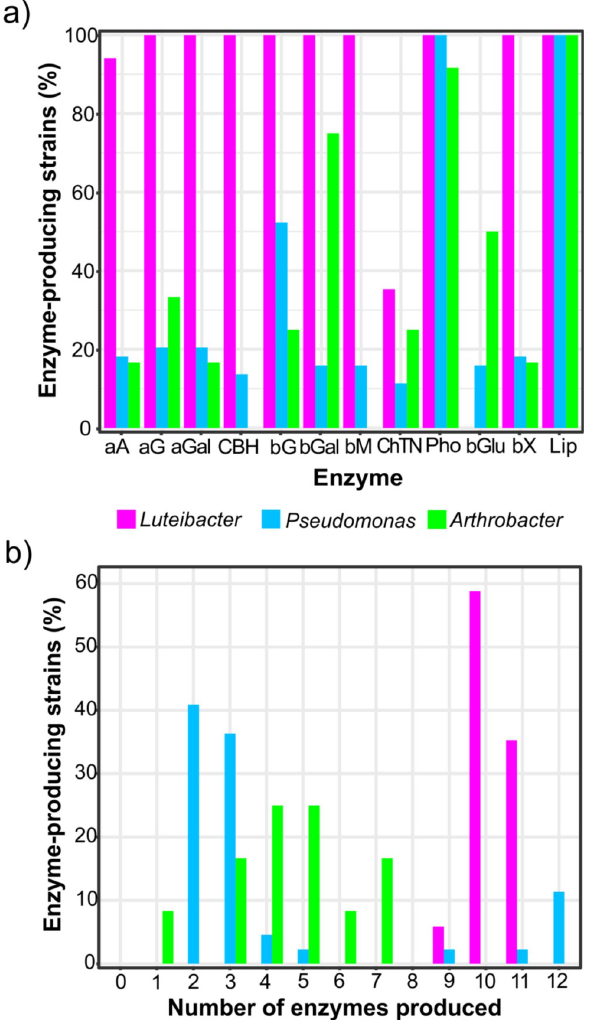
Fig 4. Relationship of the number of enzymatic activities and bacterial strains. (a) Percentage of Luteibacter , Pseudomonas and Arthrobacter strains exhibiting different enzymatic activities. (b) Enzymatic specialization of Luteibacter , Pseudomonas and Arthrobacter strains. The degree of specialization of each genus was measured as the total amount of strains producing different number of enzymes in liquid cultures. Abbreviations of enzymes: aA : α - arabinosidase; aG : α -glucosidase; aGal : α -galactosidase; CBH: cellobiohydrolase; bG: β -glucosidase; bGal : β - galactosidase; bM : β -mannosidase; ChTN: chitinase; Pho: acid phosphatase; bGlu : β -glucuronidase; bX : β -xylosidase; Lip: